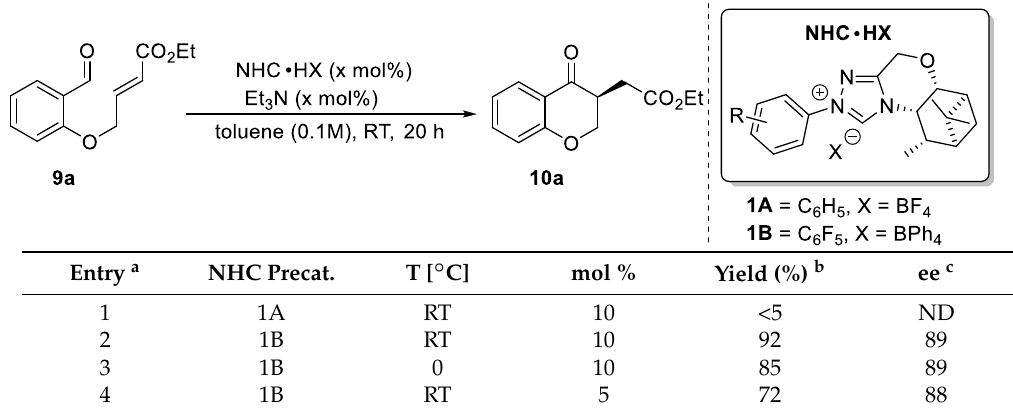
Table 1. NHC catalyst screening.